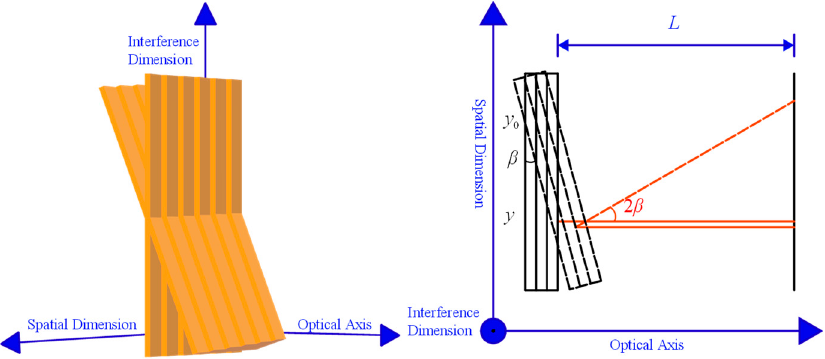
Figure 4. Slope error structure.